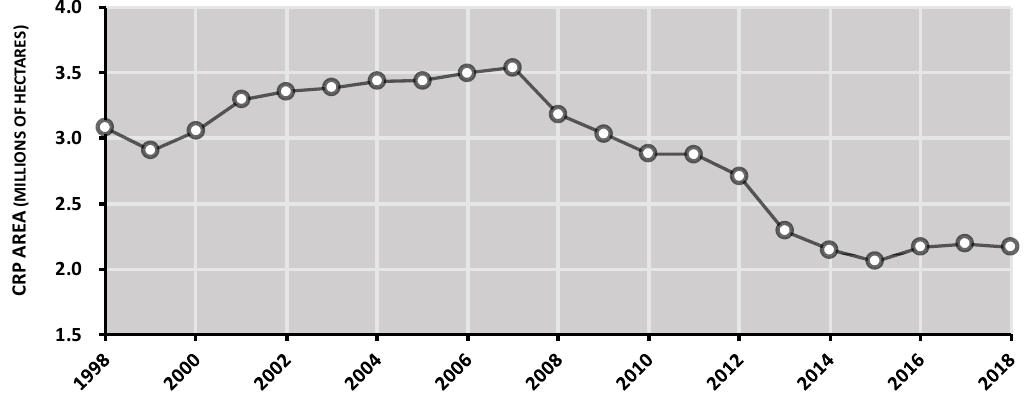
Figure 9. Sum of total area enrolled in the Conservation Reserve Program (CRP) for 1998–2018 in the four states (Iowa, Minnesota, North Dakota, and South Dakota), where most of the US–PPR can be found [47] . Note the abrupt decreases in area enrolled in CRP between 2007–2008 and 2012–2013.